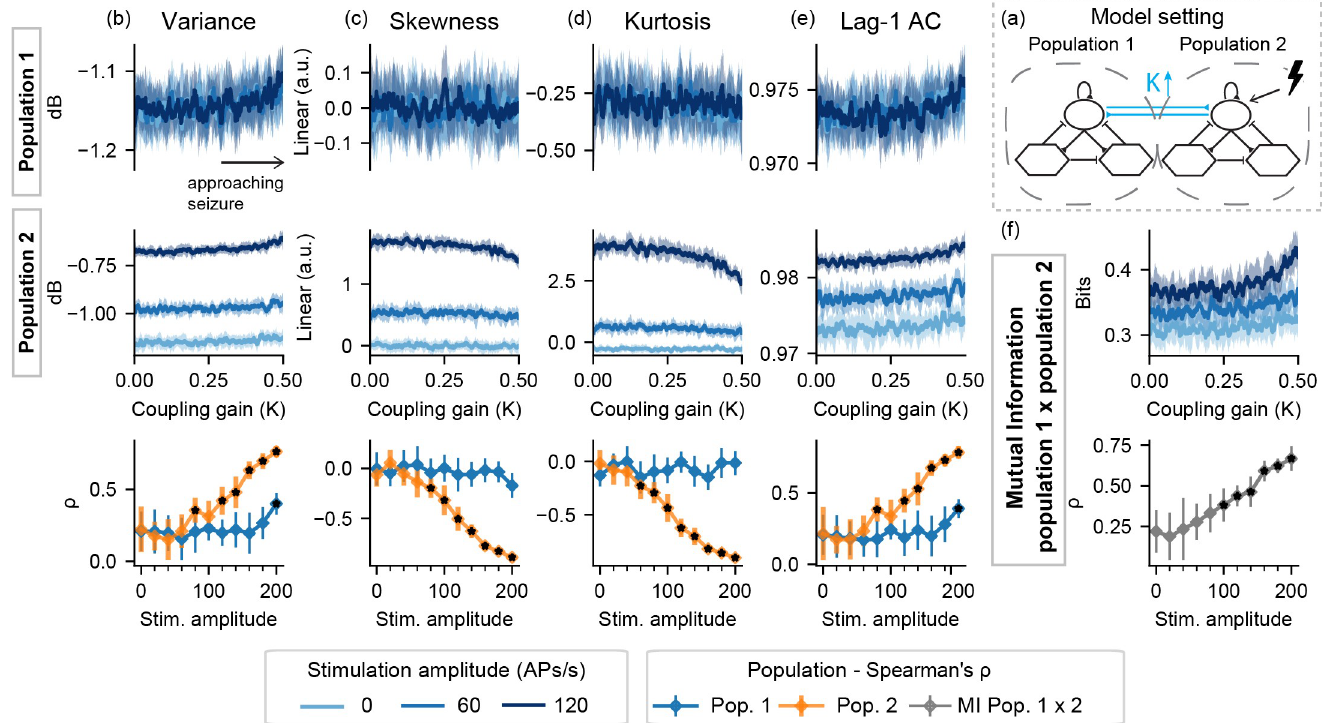
Fig 5. Feature series and probing efficiency for model setting I-K. Coupling gain increase is highlighted by features extracted from the stimulated population and by the mutual information between activities of both model subsets. (a) shows a simplified illustration of the model setting. For (b) variance, (c) skewness, (d) kurtosis and (e) lag-1 AC features, top rows show feature values extracted from the output of each population, as the coupling gain gain parameter (K) is increased. (f) shows the inter-population synchronization as measured by the mutual information feature. Bottom row shows Spearman’s rank correlation between each feature series and the shifted parameter (K), as stimulus amplitude is